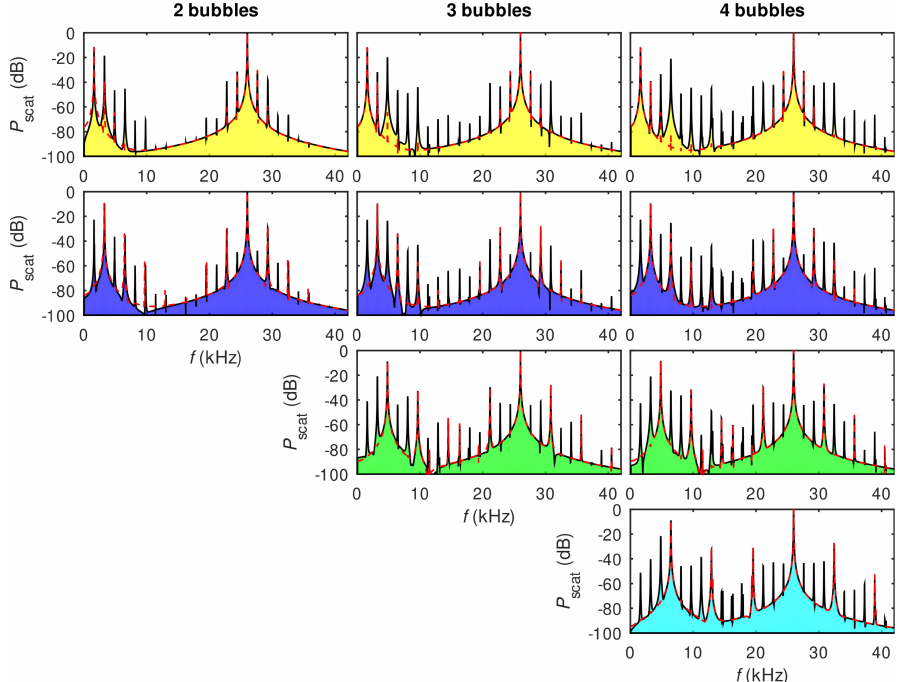
Figure 13. Columns (from left to right) show the AFC spectra produced by individual bubbles within clusters consisting of two, three and four bubbles with the equilibrium radii R n 0 = 1.95/ n mm, where n is the bubble index in the cluster. The number of panels in each column corresponds to the total number of bubbles. The red dashed lines in each panel show the spectra of individual non-interacting stationary bubbles with identical equilibrium radii. Computational parameters are given in